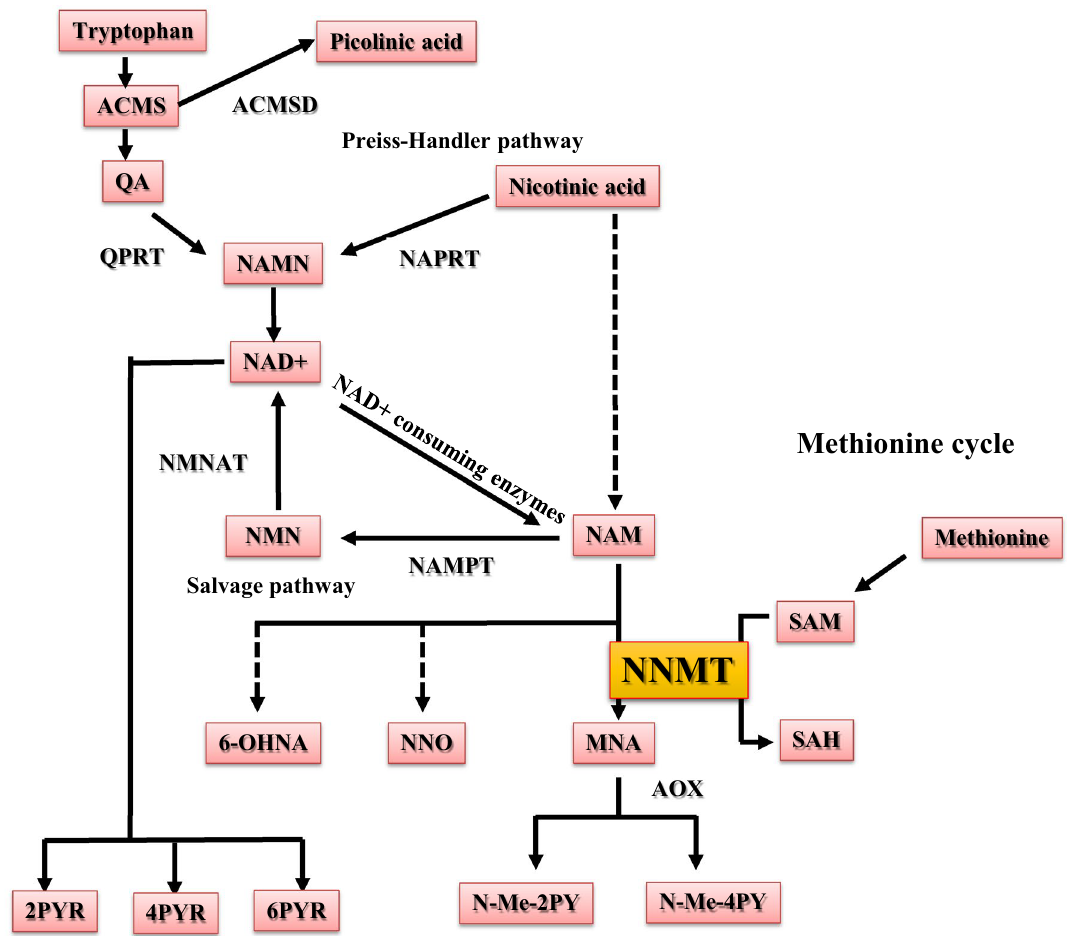
Figure 1. NNMT regulates NAD + and methionine metabolism. NAD + -consuming enzymes (Sirtuins, PARPs, cADPR synthases) degrade NAD + to NAM. NAM is converted to NMN by NAMPT for reuse in NAD + biosynthesis (salvage pathway). Otherwise, NAM is metabolized to MNA by NNMT. NNMT uses SAM as a methyl donor and yields MNA and SAH from NAM. N-Me-2PY and N-Me-4PY are the major final NAM metabolites. In addition to the salvage pathway, there are two pathways of NAD + synthesis; the de novo pathway, in which NAD + is synthesized from tryptophan via alpha-amino-beta-carboxy-muconate- semialdehyde (ACMS), quinolinic acid (QA), and nicotinic acid mononucleotide (NAMN) by quinolinate phosphoribosyltransferase (QPRT), and the Preiss–Handler pathway, in which NAD + is synthesized from nicotinic acid (NA) via NAMN by nicotinate phosphoribosyltransferase (NAPRT). ACMS is degraded to picolinic acid by alpha-amino-beta-carboxy-muconate-semialdehyde decarboxylase (ACMSD). NAM, nicotinamide; NAD + , nicotinamide adenine dinucleotide; NMN, nicotinamide mononucleotide; PARP, poly ADP ribose polymerase; cADPR, cyclic ADP ribose; NAMPT, nicotinamide phosphoribosyltransferase; NNMT, nicotinamide N-methyltransferase; NMNAT, nicotinamide mononucleotide adenylyltransferase; MNA, 1-methylnicotinamide; NNO, nicotinamide-N-oxide; 6-OHNA, 6-hydroxynicotinic acid; N-Me-2PY, N-methyl- 2-pyridone-5-carboxamide; N-Me-4PY, N-methyl-4-pyridone-3-carboxamide; SAM, S-adenosylmethionine; SAH, S-adenosylhomocysteine; ACMS, alpha-amino-beta-carboxy-muconate-semialdehyde; ACMSD, alpha-amino-beta-carboxy-muconate-semialdehyde decarboxylase; QA, quinolinic acid; QPRT, quinolinate phosphoribosyltransferase; NAMN, nicotinic acid mononucleotide; NA, nicotinic acid; NAPRT, nicotinate